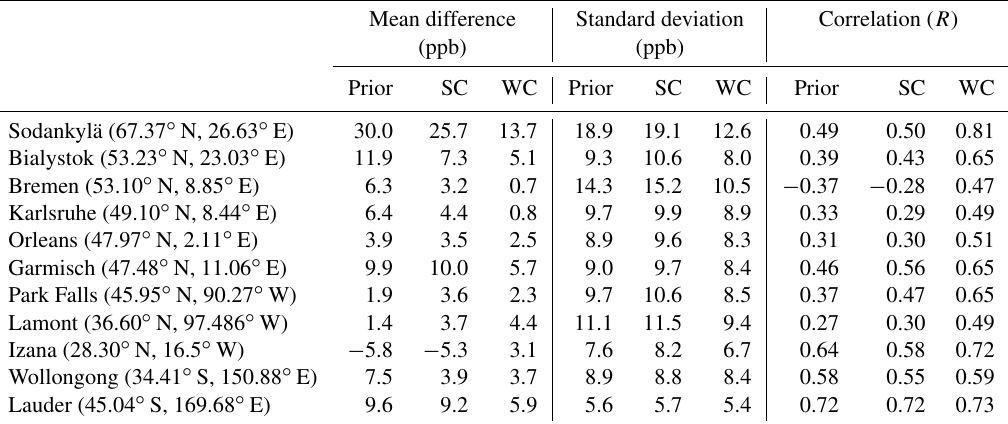
Table 2. Evaluation of a priori, SC_4x5, and WC_4x5 optimized CH 4 fields using TCCON XCH 4 (mean station-wise statistics for the period of February–May 2010). The first, second, and third columns represent the mean difference, standard deviation, and correlation between the model and measurements, respectively.